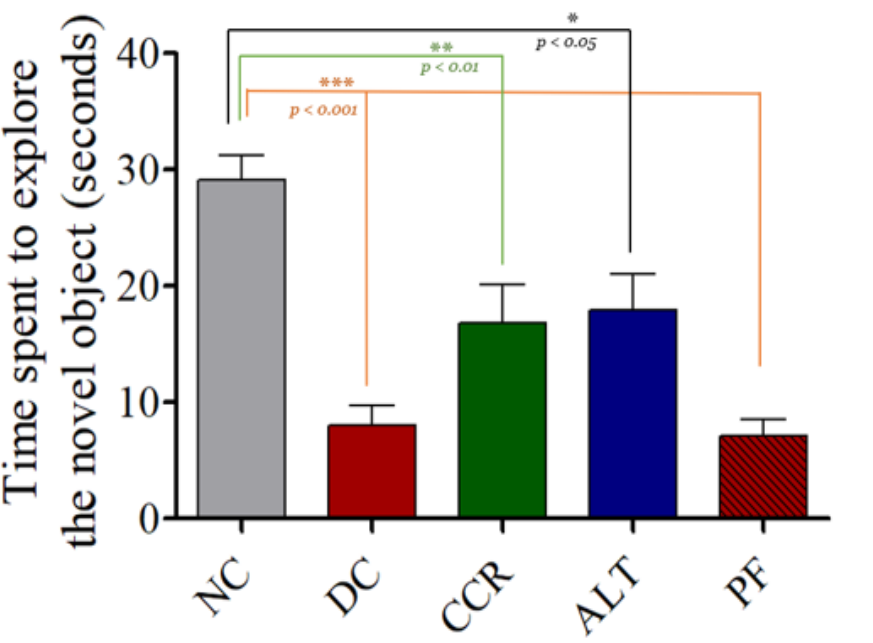
Figure 5. Effects of various fasting protocols on cognitive function using novel object recognition. Data represented as the mean ± standard error of the mean (SEM); * indicates significant difference between the control group and the various fasting protocols (* p < 0.05, ** p < 0.01 and *** p < 0.001 vs. control group): DC and PF ( p < 0.001), CCR ( p < 0.01), ALT ( p < 0.05); results of one- way ANOVA. NC = Control, DC = Diabetes, CCR = Continuous calorie restriction, ALT = Alternate day calorie restriction, PF = Calorie restriction for 2 days.